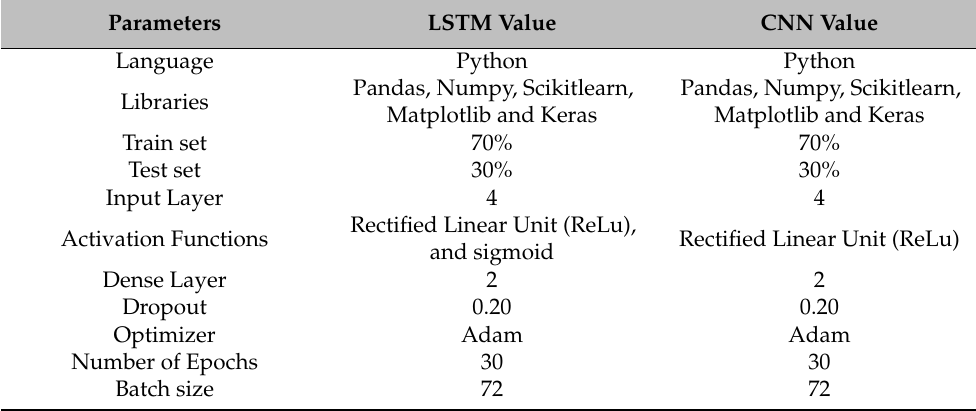
Table 9. Deep learning models’